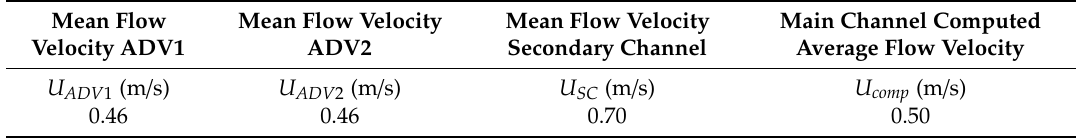
Table 8. Average velocity of the flow in the main and secondary channel acquired by different methods and the computed velocity of the flow for Test 04_B in phase B.